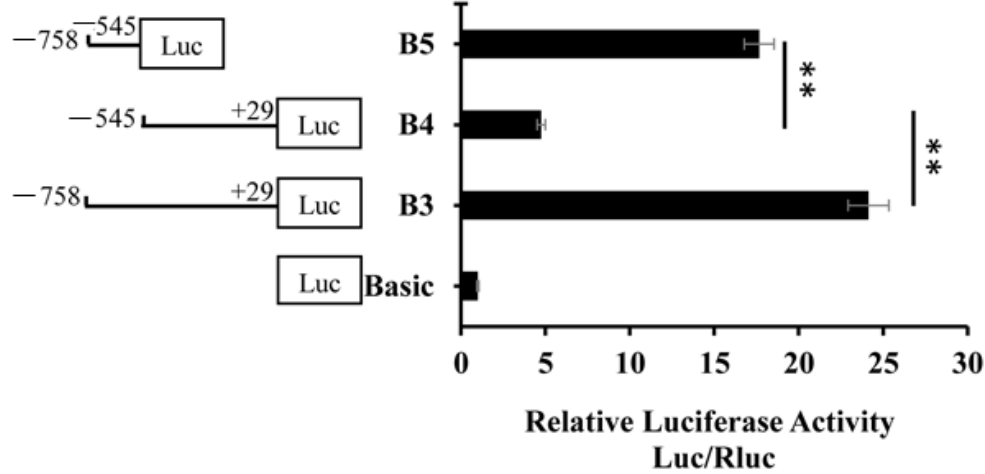
Figure 3. Activity analysis of the −758 bp to −545 bp region of the Hu sheep BMP7 promoter. Note that for B5, the target fragment (−758 bp to −545 bp) was ligated to the pGL3-Base vector; B3 was the normal control group. The marker “**” represents a highly significant difference ( p < 0.01).